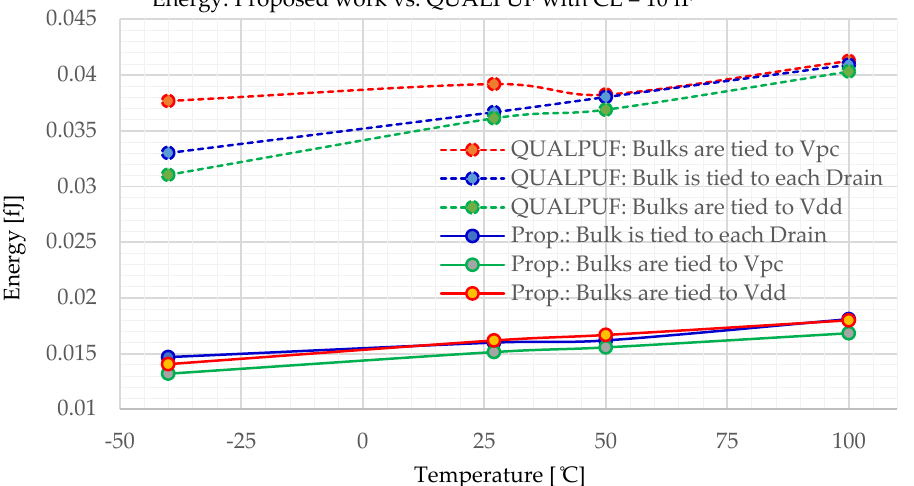
Figure 8. PUF cell energy dissipation of the proposed adiabatic PUF versus QUALPUF under the PMOS body effect.